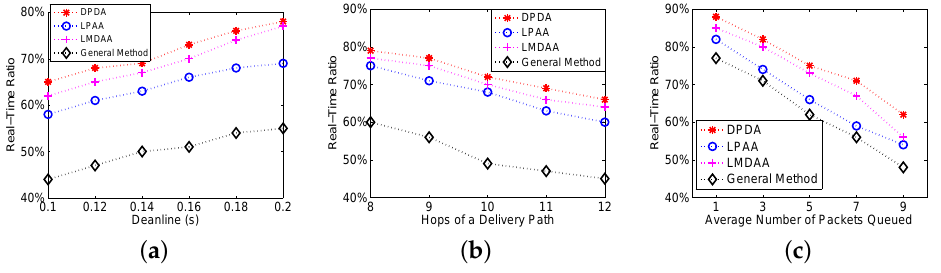
Figure 4. Real-Time Ratio (RTR) of the proposed algorithms. ( a ) RTR vs. deadlines; ( b ) RTR vs. number of hops; ( c ) RTR vs. the average number of packets